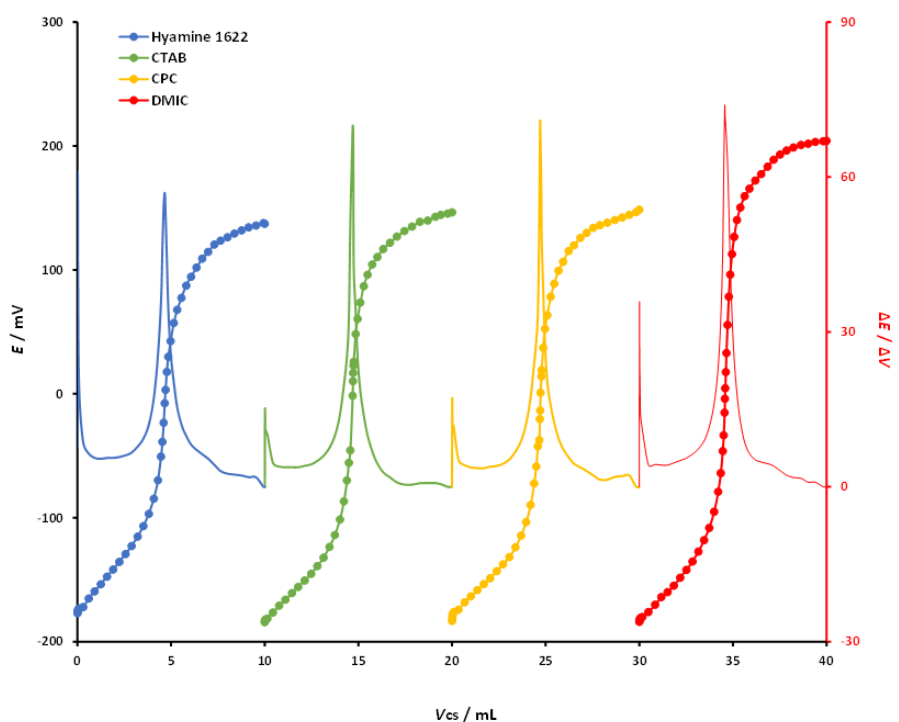
Figure 4. Potentiometric titration curves, and first derivatives, of DBS (0.4 mM) with four different cationic surfactants (0.4 mM) used as a titrant: Hyamine 1622, CTAB, CPC, and DMIC. The titration curves and their first derivatives were rearranged for the sake of clarity.